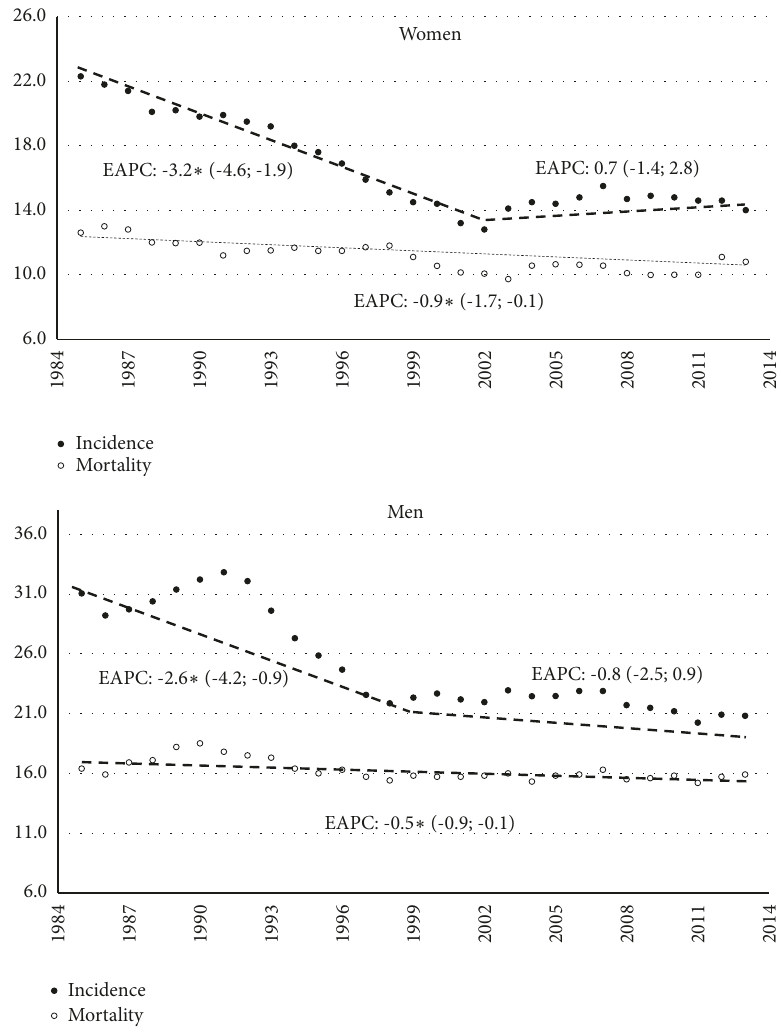
Figure 1: Standardized incidence and mortality rates for gastric cancer in women and men, including EAPC based on joinpoint models. Y: Age-standardized rates per 100,000 person-years; X: Year of diagnosis/death. EAPC: Estimated Annual Percent Change, figures between brackets are 95% CI of EAPC; a star indicates statistical significance at 𝛼